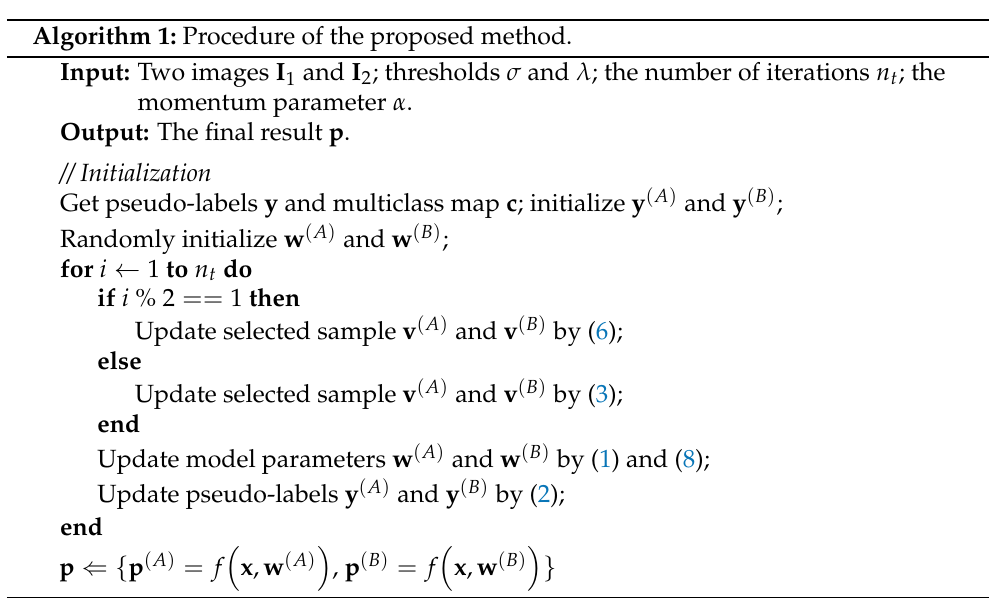
Algorithm 1: Procedure of the proposed